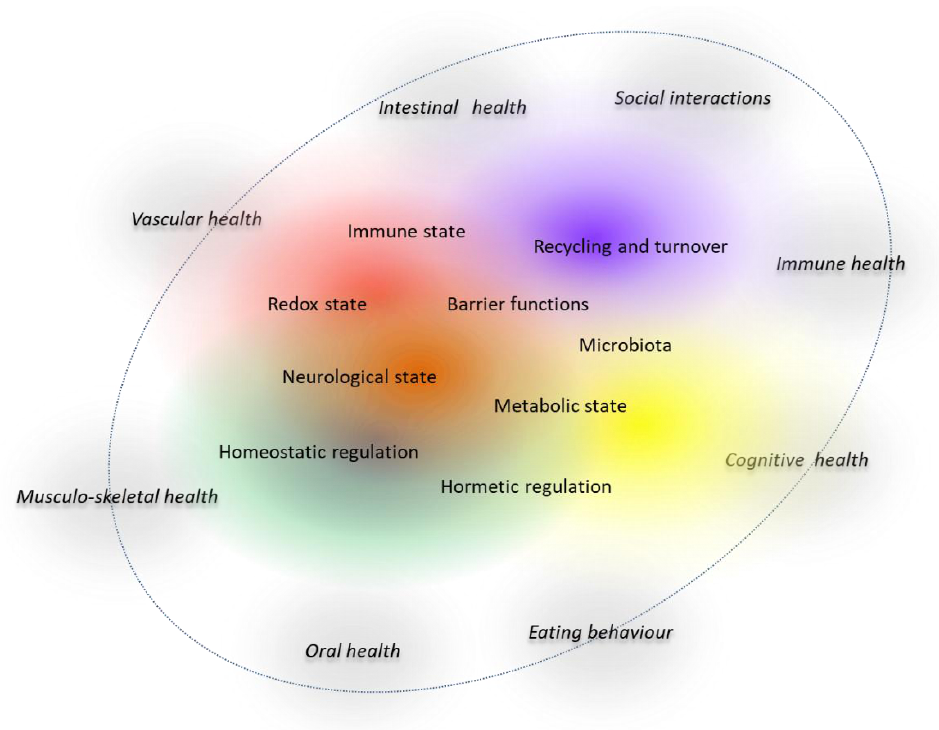
Figure 4. ‘Health interactome’ concept to visualise the regulation of different-largely interrelated-health domains by an intertwined set of biological key processes (hallmarks of health) that maintain normal physiology.